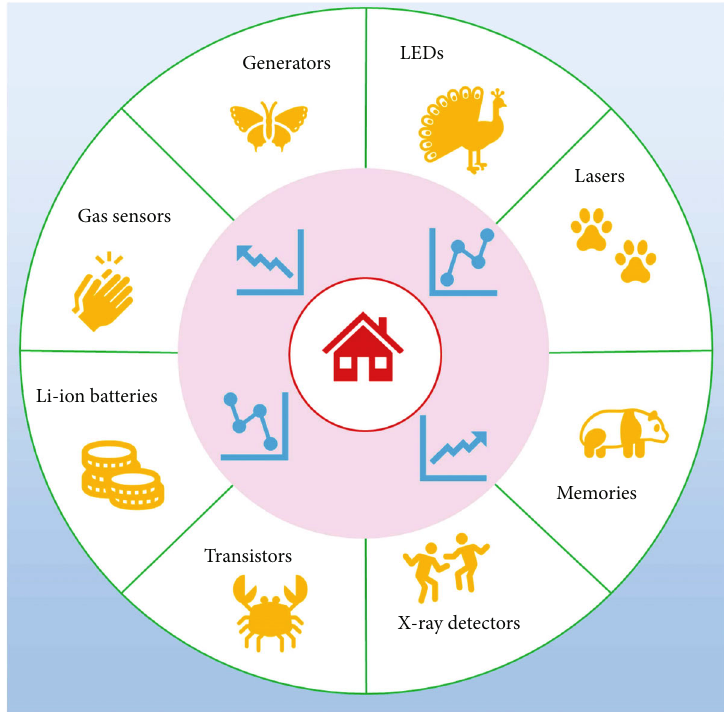
Figure 1: Applications of perovskites in fi elds other than